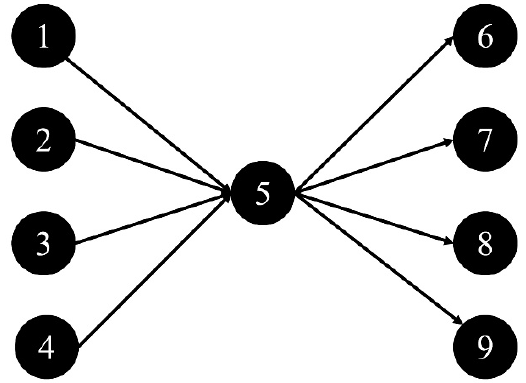
Figure 2. A sample model of IATN.